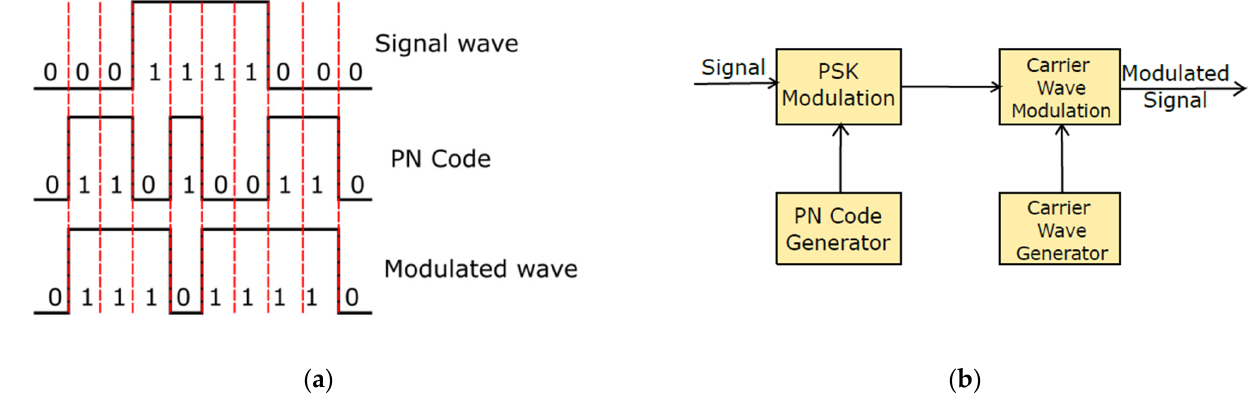
Figure 1. ( a ) Principle of DSSS. ( b ) Block diagram for DSSS